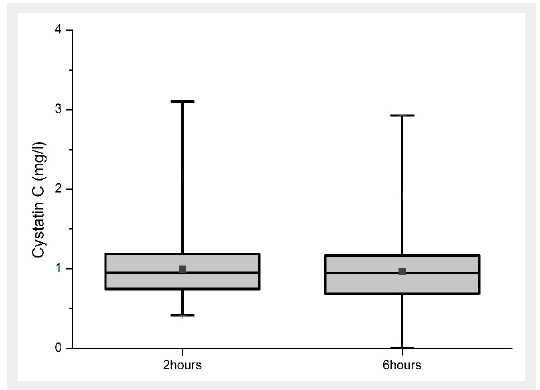
Box and whisker plot of urine neutrophil gelatinase-associated lipocalin (NGAL) values in all patients 2 hours and 6 hours after the end of cardiopulmonary bypass. Boxes: 25 th percentile (bottom line), median (middle line), and 75 th percentile (top line); bars: range; squares: means. Note the logarithmic